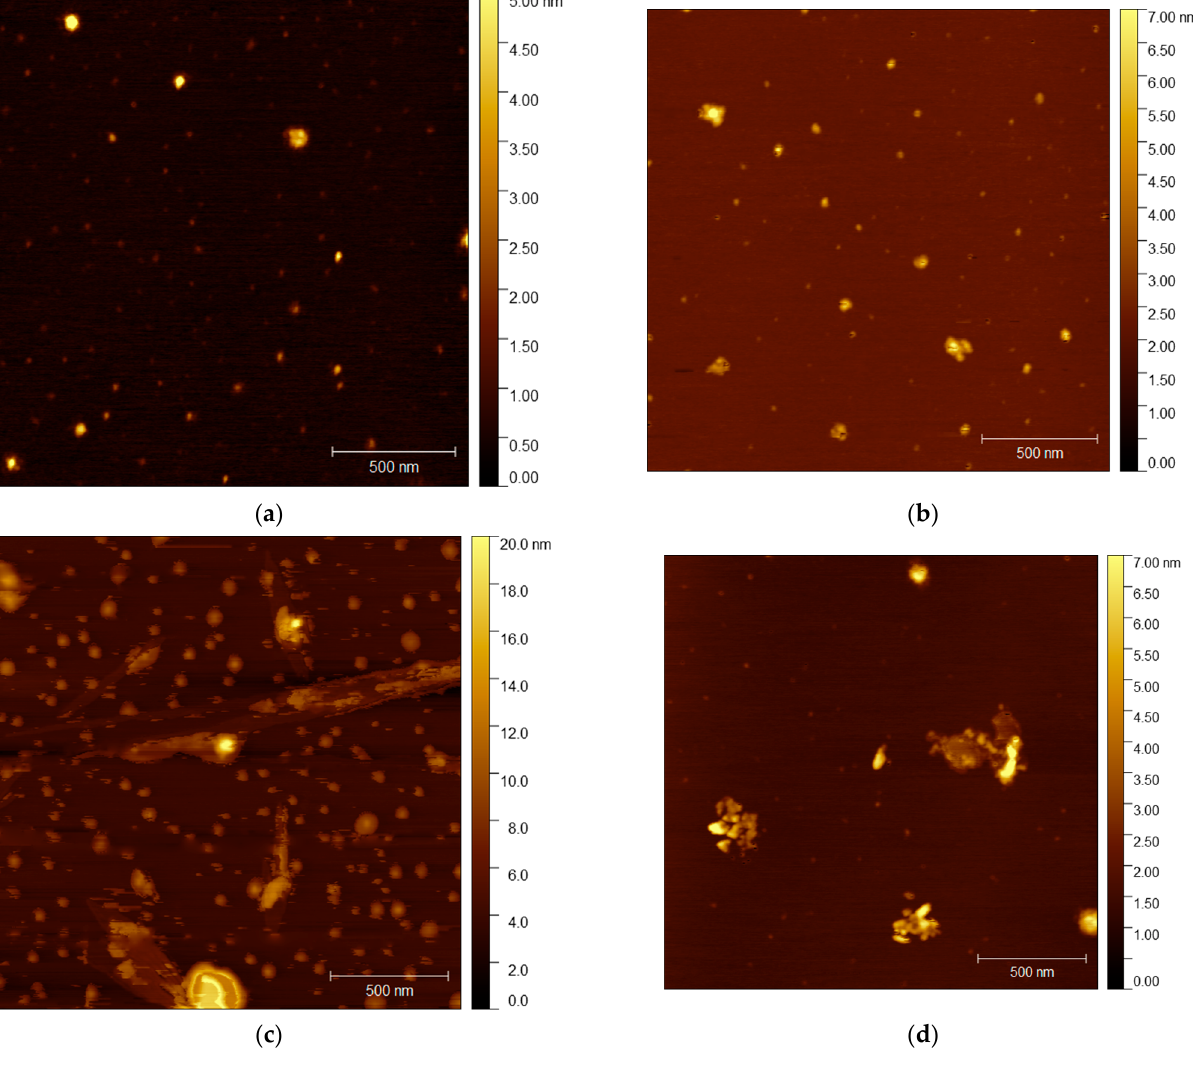
Figure A1. AFM images of Pt-NP ( a ), Pd-NP ( b ), Rh-NP ( c ) (the molar ratio of PGM:PVP:reducer was 1:1:2) and (d) Ru-NP (the molar ratio of PGM:PVP:reducer was 1:1:1) using NaBH 4.